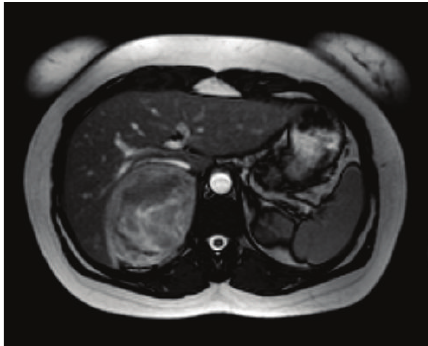
Figure 2: MRI describing mass of Dmax = 9 cm between right kidney and liver, with hemorrhagic elements.